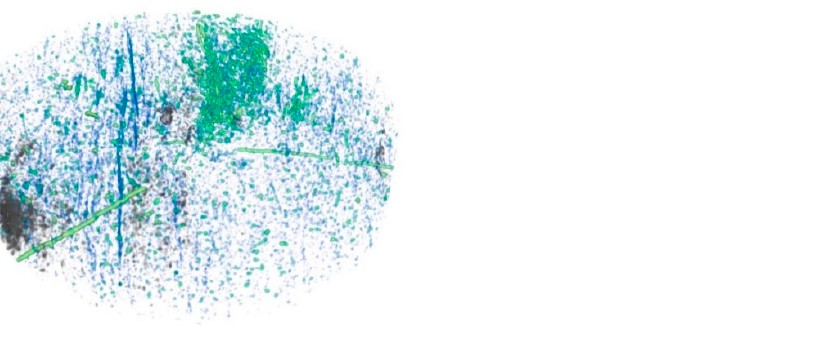
Figure 11. Fluid content that is highly likely to be the water phase superimposed on the density variations of the core plug (A video is provided in the Supplementary